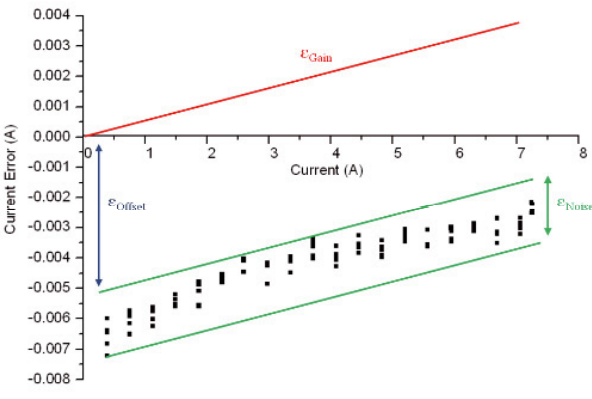
Fig. 11. Influence of Errors on current